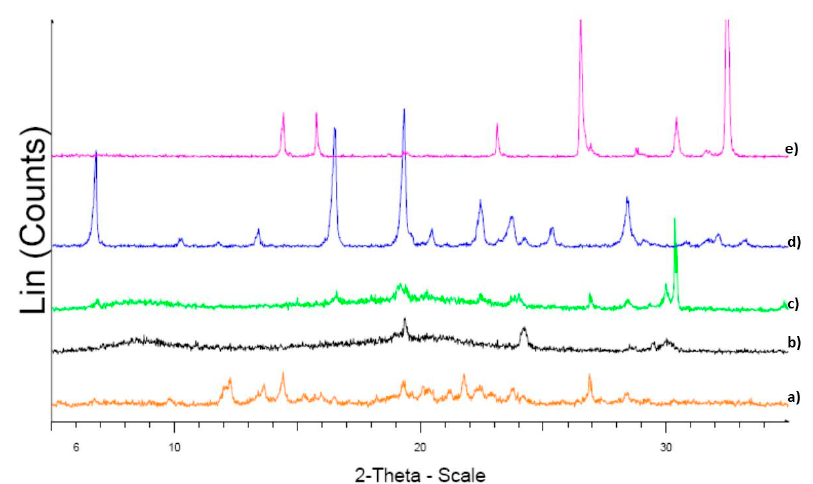
Figure 3. Pattern X-ray powder di ff raction (XRPD) of ( a ) Nacesol TM ; ( b ) Cyclodextrin; ( c ) physical mixture (MF) NAC: Resveratrol: cyclodextrin (10:15:75 w:w:w); ( d ) Resveratrol; ( e )